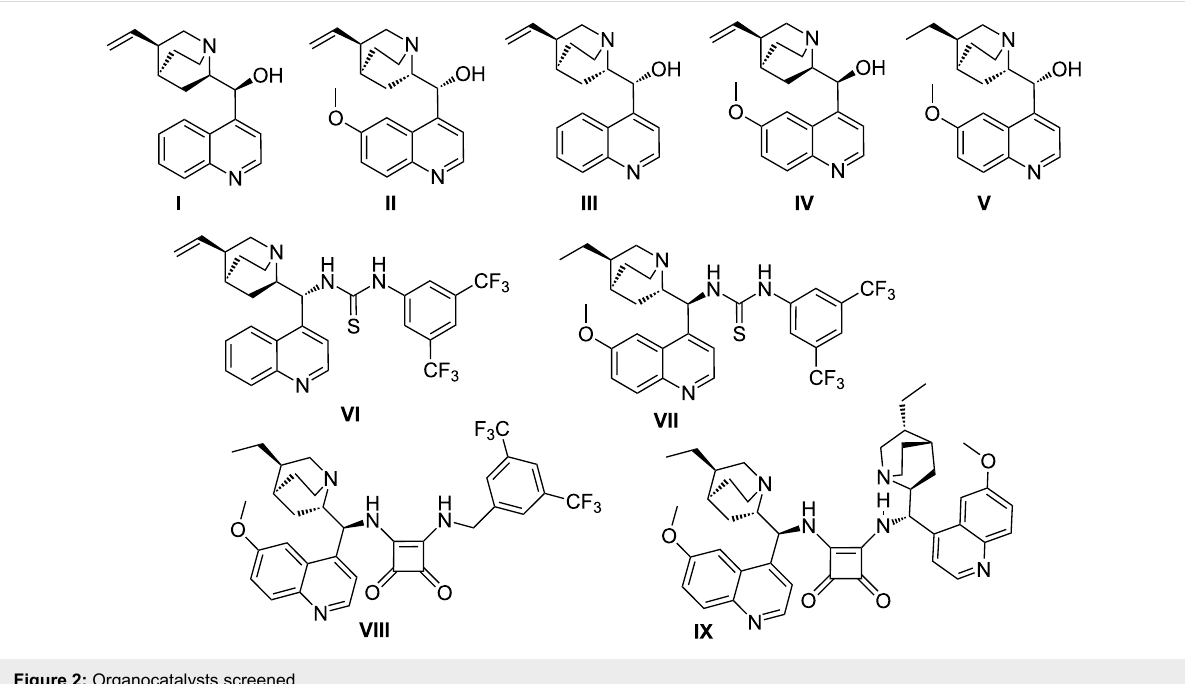
Figure 2: Organocatalysts screened.